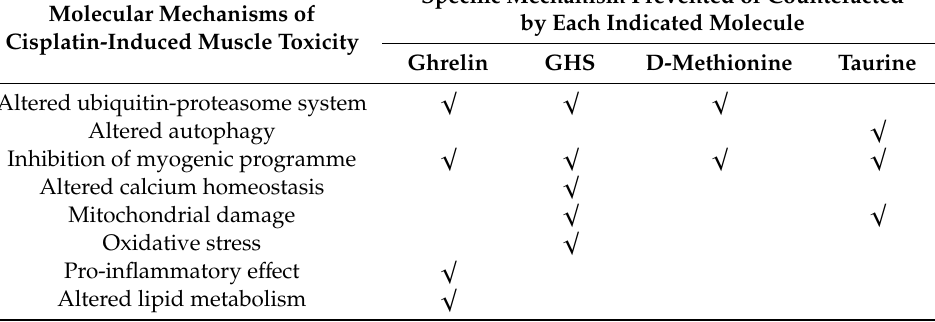
Table 1. Ghrelin, GHS, D-methionine and Taurine: mechanisms of action in counteracting muscle-cisplatin induce